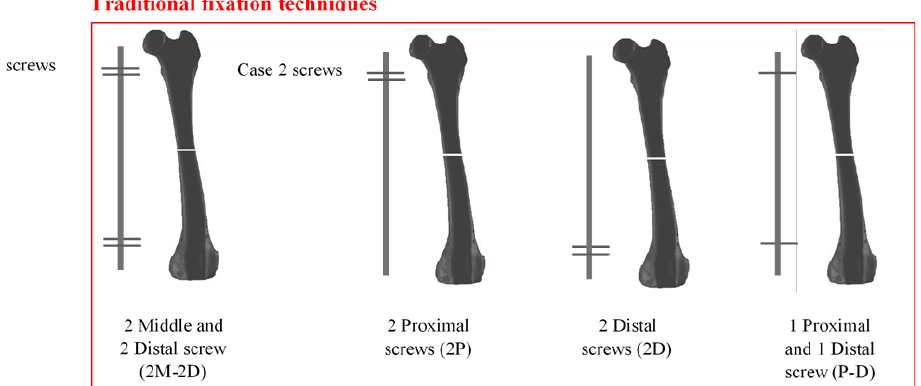
Figure 3. The FEA models with middle canine femoral shaft fractures and fixation techniques. Table 1. Properties of materials used to compose the models of the composite interlocking nail system.